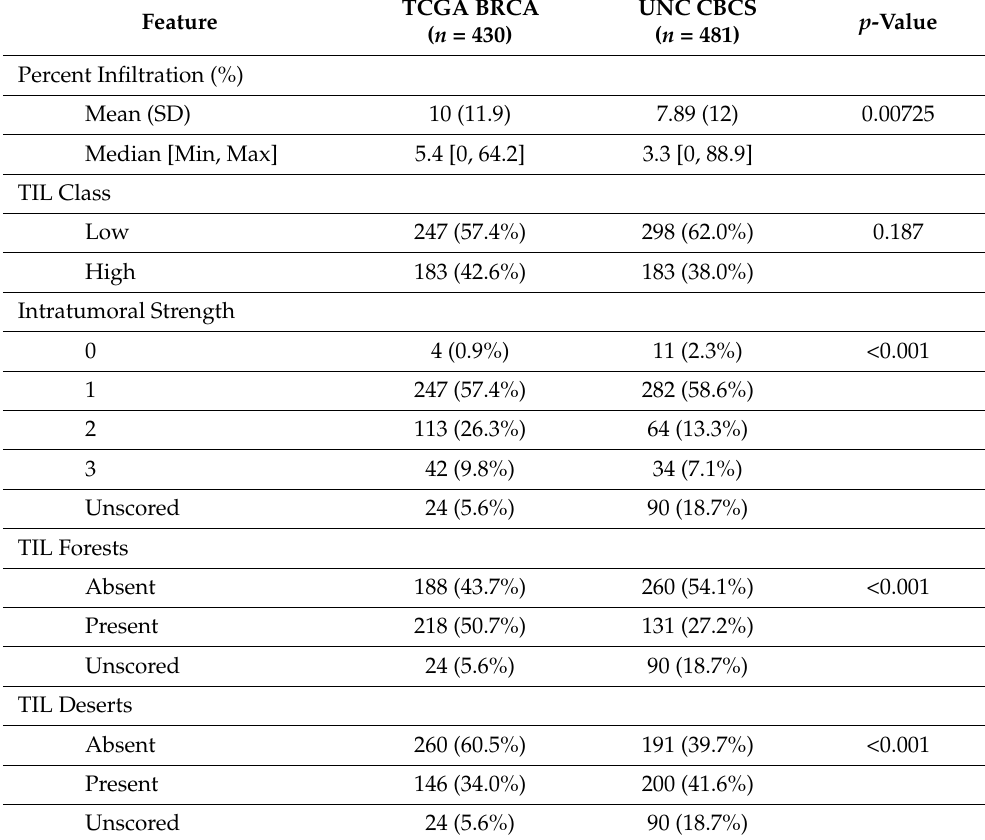
Table 3. Comparison of spatial features in the “TIL sensitive” cohorts of TCGA BRCA and UNC- UNC